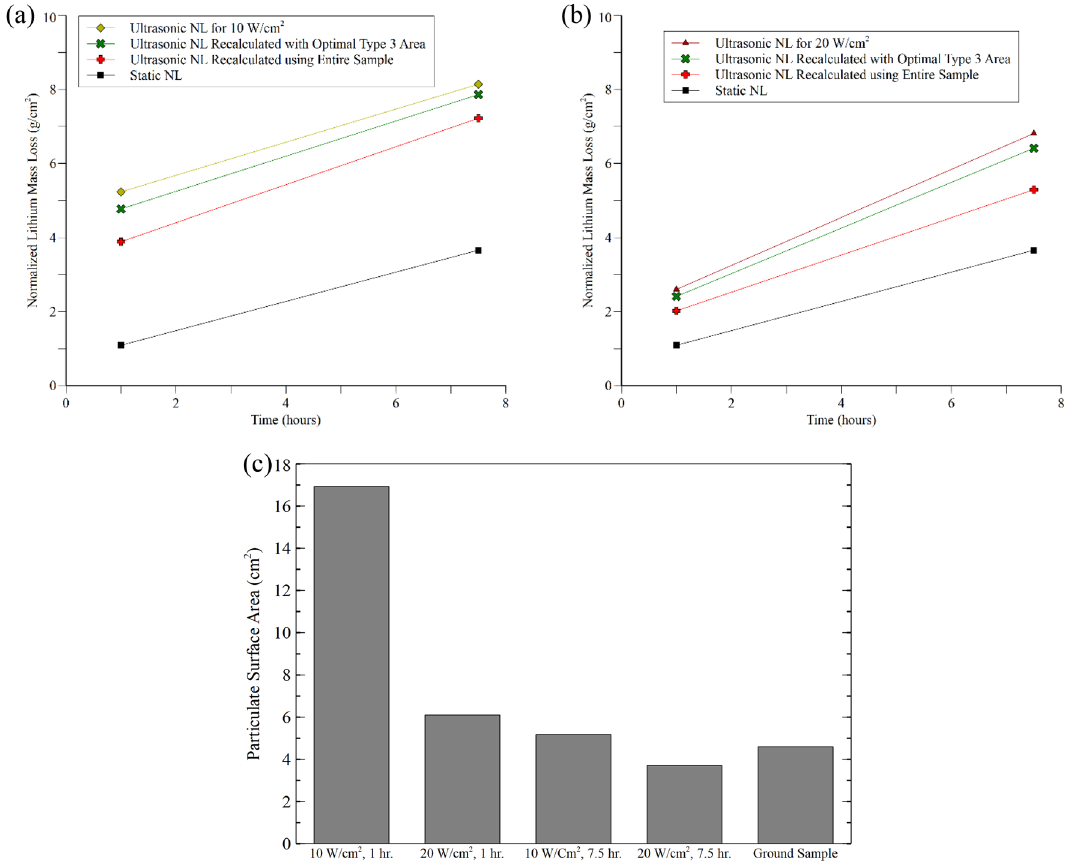
Figure 8. Original and recalculated normalized lithium mass loss for 10 W cm −2 ( a ) and 20 W cm −2 ( b ) results using Veusz. Recalculations were completed assuming a sample experienced Type 3 erosion in the shape of the homogenizer horn (optimal conditions) or with the extreme assumption of the entire sample experiencing Type 3 erosion. Even in the extreme case where the entire sample experienced erosion, the recalculated normalized mass loss is still higher than static dissolution results. The additional particulate surface area required to make the ultrasonic results equivalent to static results is shown in the bar chart ( c ). The average surface area of a ground, uncorroded sample is included in the chart for comparison. For most results the particulates would need to create additional surface area equivalent to a second unleached